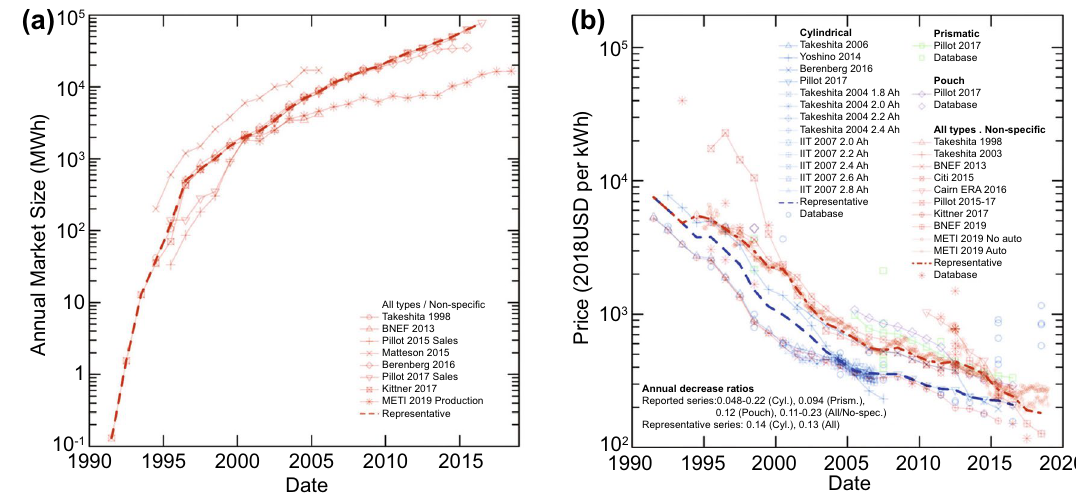
Fig. 4 The change in a annual market size, and b price of LIBs since their introduction in 1991 [40] . Creative Commons License (CC BY-NC